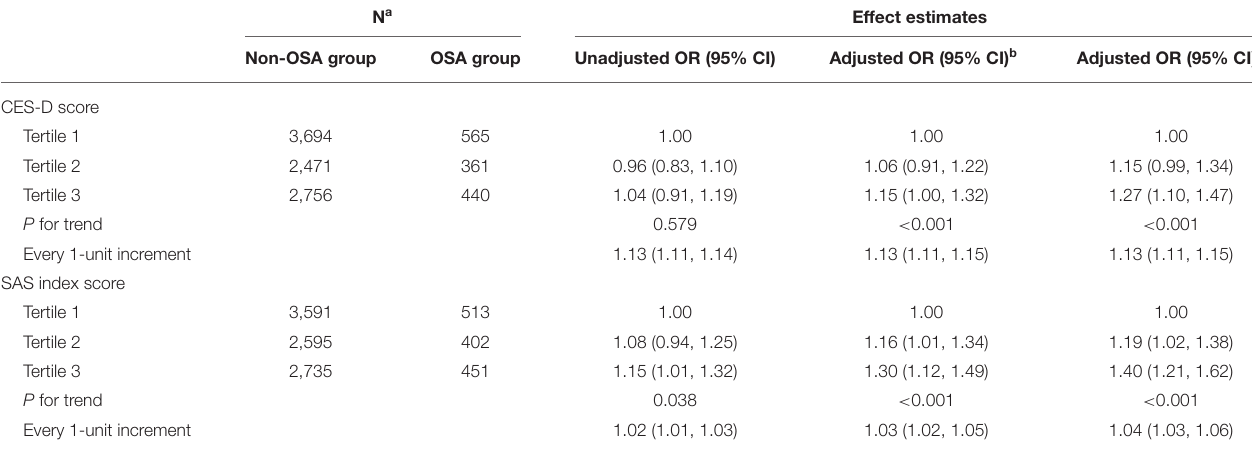
TABLE 3 | Association of CES-D score and SAS index score with OSA